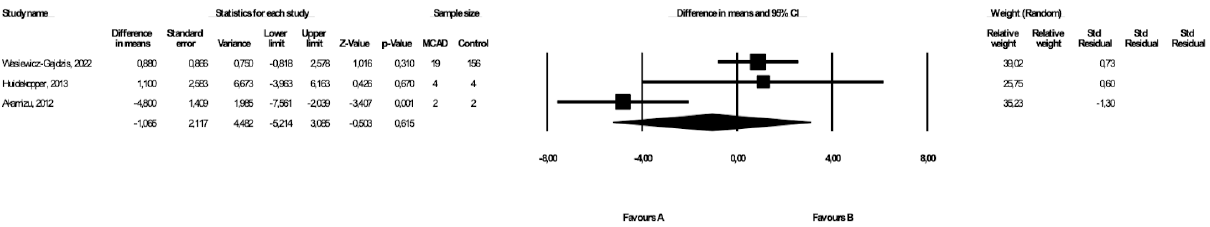
Figure 5. Forest plot—comparison of BMI in MCAD patients vs. controls [19,20].